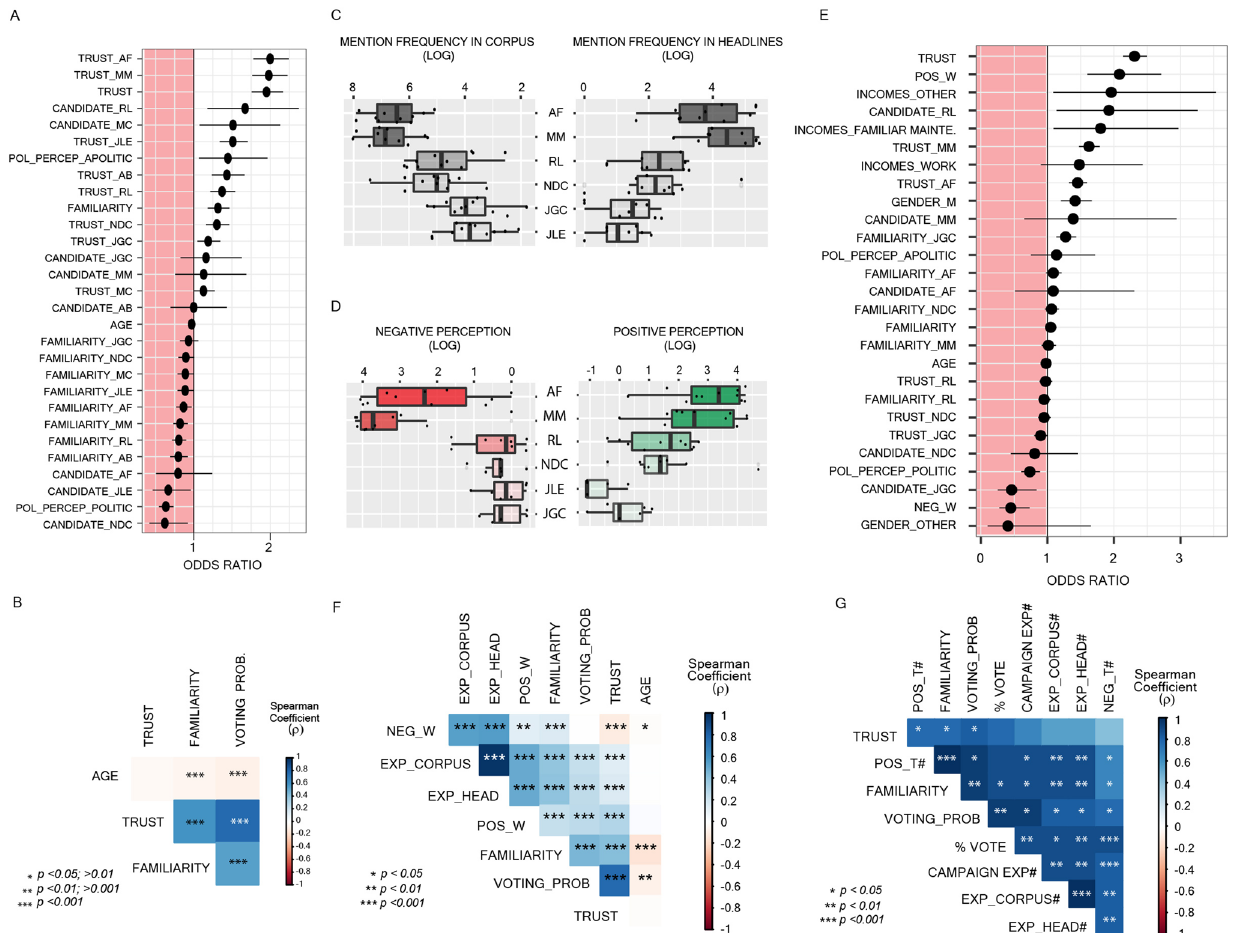
Figure 5. Social Study: 2019 Argentine President General Election. ( A ) Odds ratios ± confidence intervals of the final model with only the significant variables for Period #1. ( B ) Spearman correlation matrix of variables for each candidate (Period #1). ( C ) Frequency of each candidate’s mention in either the corpus or the title of the newspaper articles published between September 21 and October 27, 2019, in the main written media. Each dot corresponds to each medium’s candidate mention. The presented order of candidates corresponds to the order of the election results; the intensity of the grey filler corresponds to the number of obtained votes. ( D ) Sentiment analysis of the news’ headlines that mentioned at least one candidate or political force. Figure shows positive or negative targets assessed as subjects’ perception. Each dot corresponds to each medium’s candidate positive or negative target. The presented order of candidates corresponds to the order of the election results; the intensity of the red (negative) or green (positive) filler corresponds to the number of obtained votes. ( E ) Odds ratios ± confidence intervals of the significant variables of the ordinal model. ( F ) Spearman Correlation matrix of variables for each candidate. ( G ) Spearman Correlation matrix of the means of each variable for each candidate and the Campaign Expenses and Election results as the percentage of vote. AF Alberto Fernandez, MM Mauricio Macri, RL Roberto Lavagna, NDC Nicolas Del Caño, JGC Jorge Gomez Centurion, JLE Jose Luis Espert, POS_T and NEG_T total positive or negative mentions in the headlines of news articles for each candidate, POS_W and NEG_W weighted positive and negative perception of each participant according to the media they use to get candidate information, POL_PERCEP political self-perception, as POLITICAL or APOLITICAL person, GENDER_M (male), EXP_CORPUS or EXP_HEAD weighted mention in news corpus or headlines according to the media that each participant used to get information about candidate. VOTING_PROB . voting probability, % VOTE percentage of votes for each candidate during General Election, CAMPAIGN_EXP declared campaign expenses of each candidate. # Expressed as LOG. *p < 0.05, **p < 0.01, ***p <